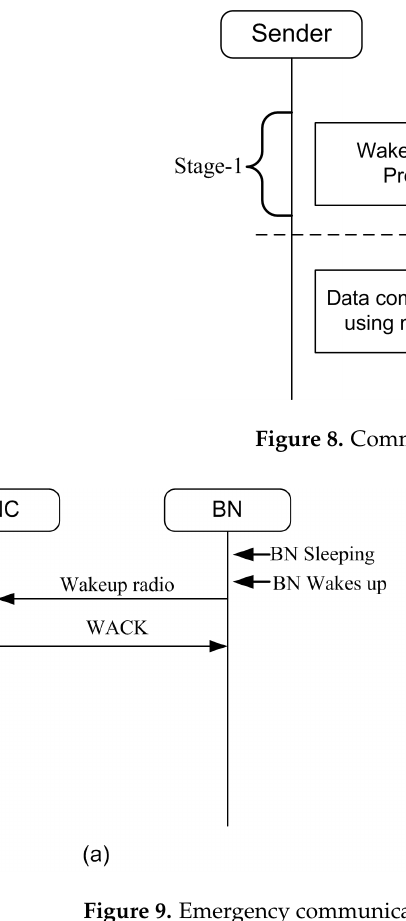
Figure 9. Emergency communication: ( a ) without data; ( b ) with